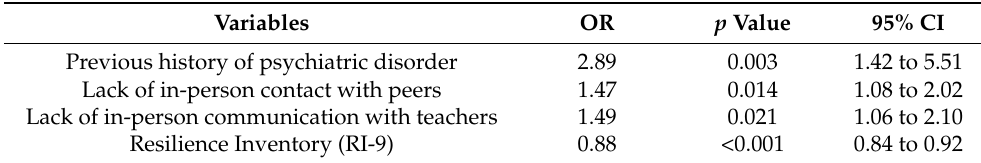
Table 2. Multivariate logistic regression model for clinically significant depressive symptoms among medical students.